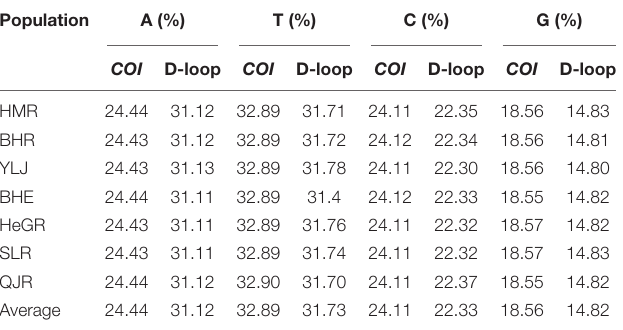
TABLE 2 | Nucleotide composition of G. przewalskii populations by two mitochondrial markers.